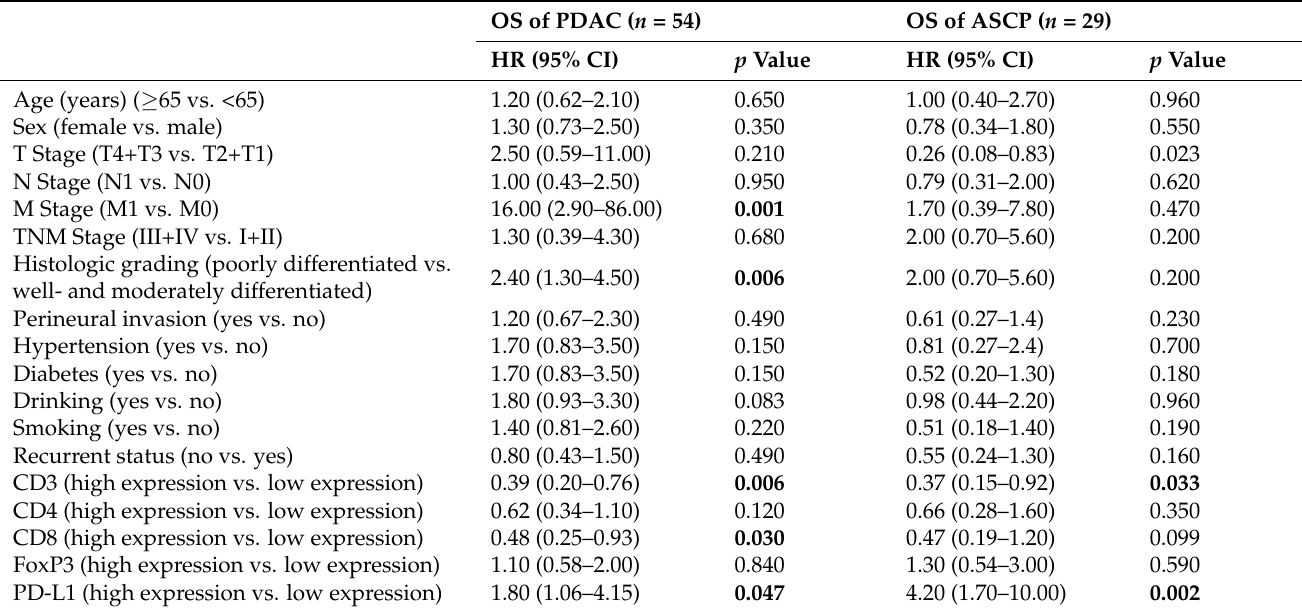
Table 2. Univariate analysis with Cox proportional hazard model.